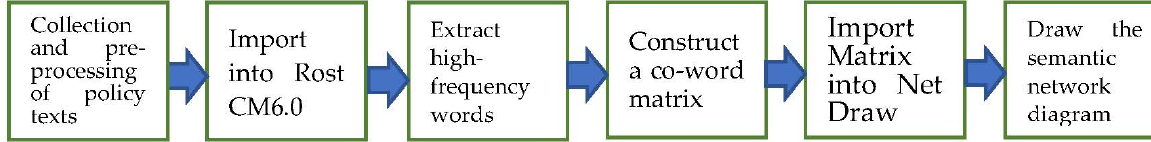
Figure 2. Process of semantic network analysis.